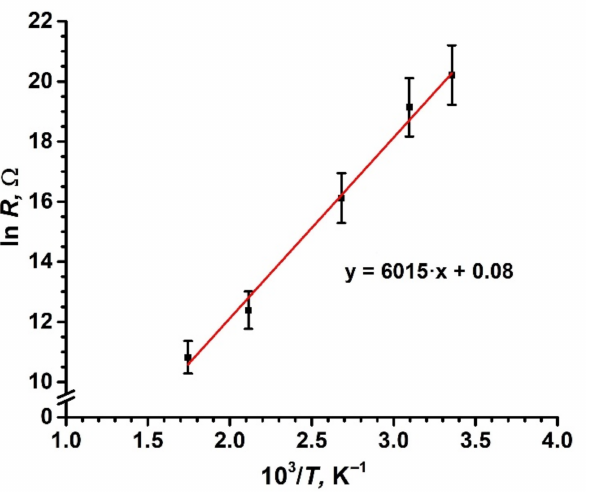
Figure A1. Temperature dependence on resistance of the unsintered line for determination of type